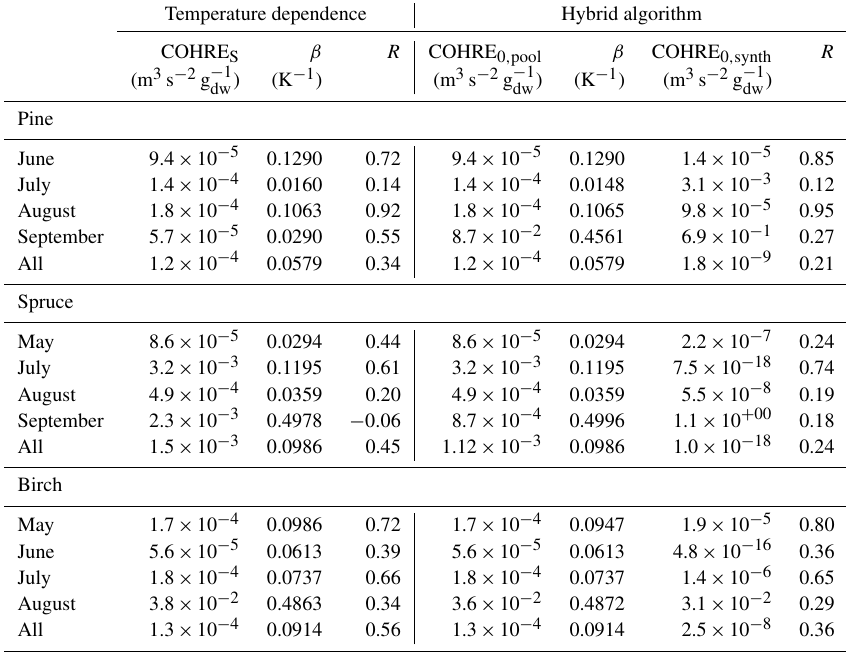
Table E1. Regression coefficients and coefficients of correlation ( R ) for temperature dependence of COHRE and for its dependence on both temperature and light using the hybrid algorithm.